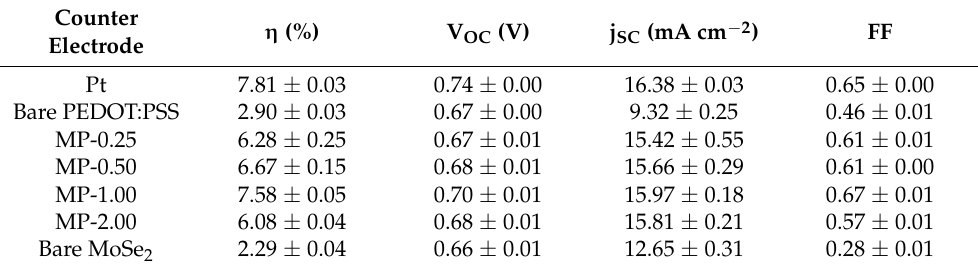
overpotential at −10 mA cm −2 (−263 mV), showing a significantly enhanced performance.